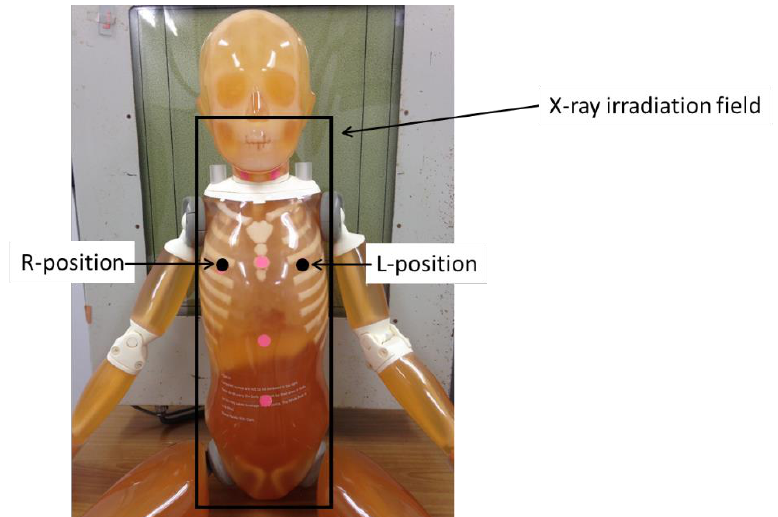
Figure 1. Geometric arrangement of measurements of breast surface doses (BSDs). Radio photoluminescence dosimeters (RPLDs) (GD-302M) were placed on the breast surface at the R-position and the L-position. The average values of the R-position and L-position measurements were used in this study.